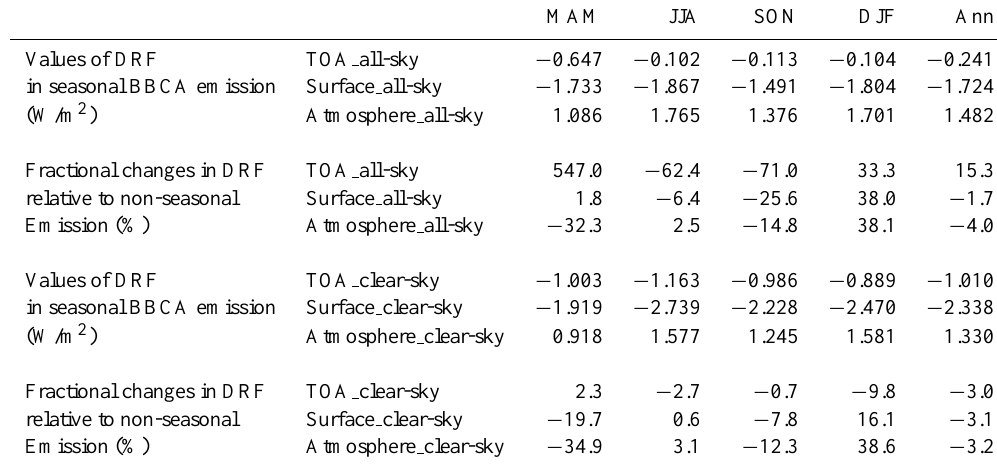
Table 2. Same as Table 1, except for online